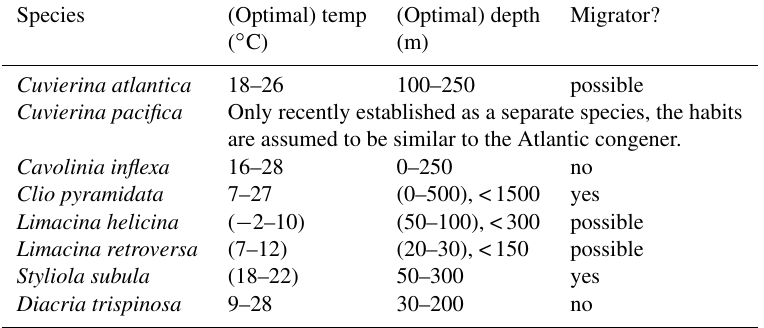
Table 1. Environmental preferences and diel vertical migratory patterns for the species used in this study based on previously published data (Bé and Gilmer, 1977; Lalli and Gilmer, 1989). Data include published full ranges at which organisms have been found, as well as previous authors’ estimates of the preferred (optimal) ranges of each species, when available. Note that these are based on relatively sparse observations of broadly distributed species, many of which may be cryptic congeners, and thus should be treated as estimates.